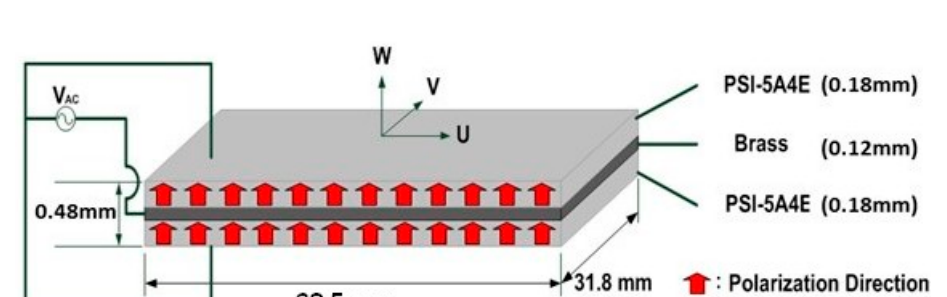
Figure 1. Schematic illustration showing the geometric dimensions of the piezoceramic bimorph in a parallel connection configuration.